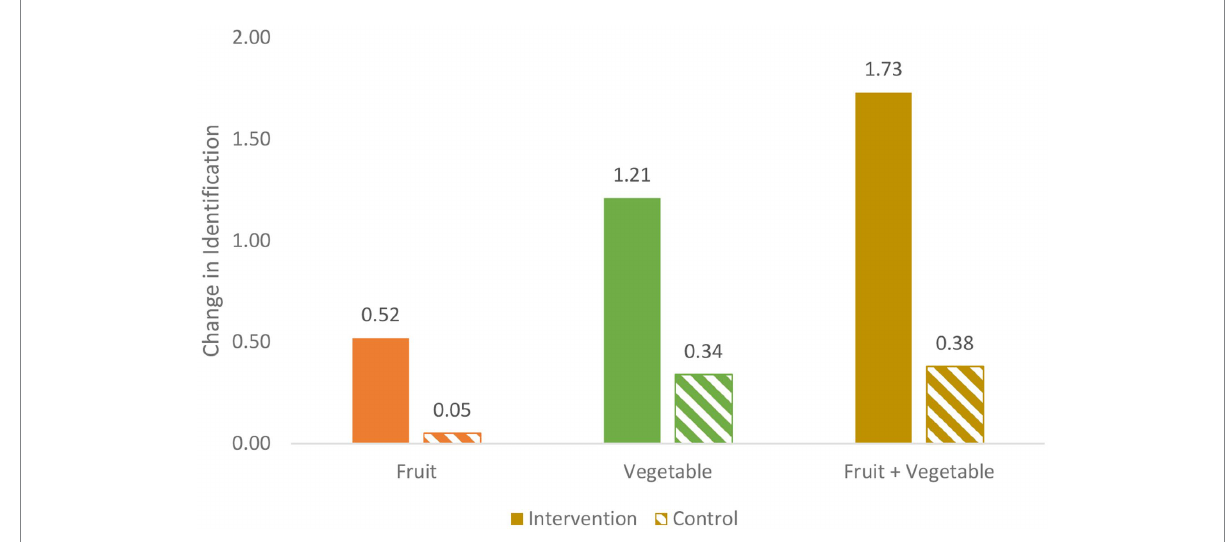
FIGURE 4 Pre-post change for intervention v. no intervention for F, V, and FV identification (number of FV).